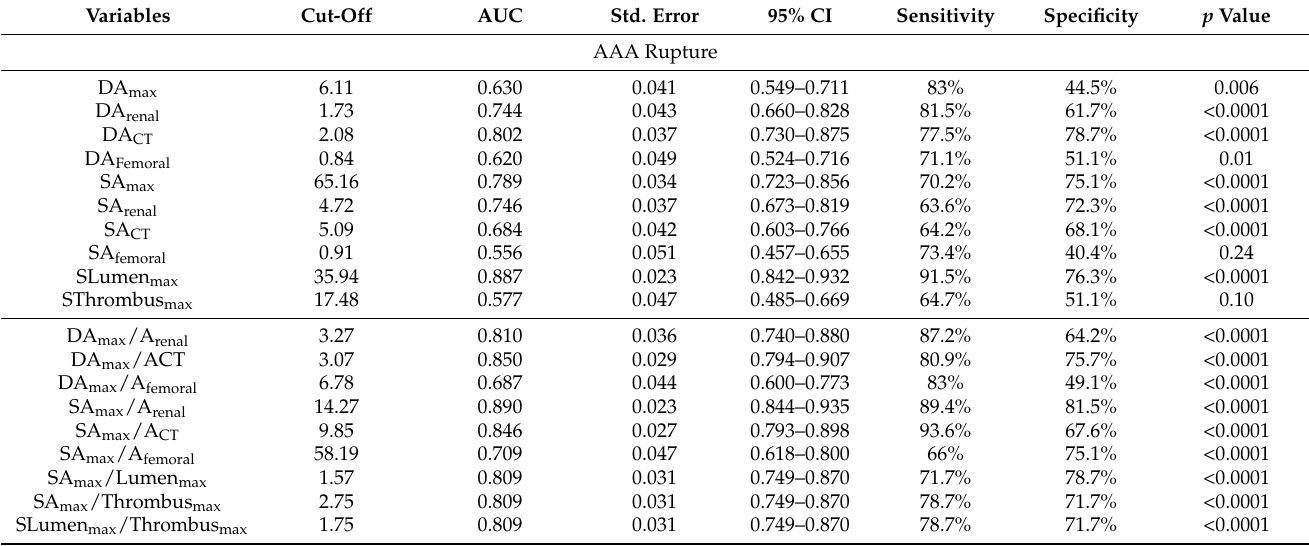
Table 3. The AUC of the ROC curve, 95% confidence interval, sensitivity, and specificity of the imaging markers.